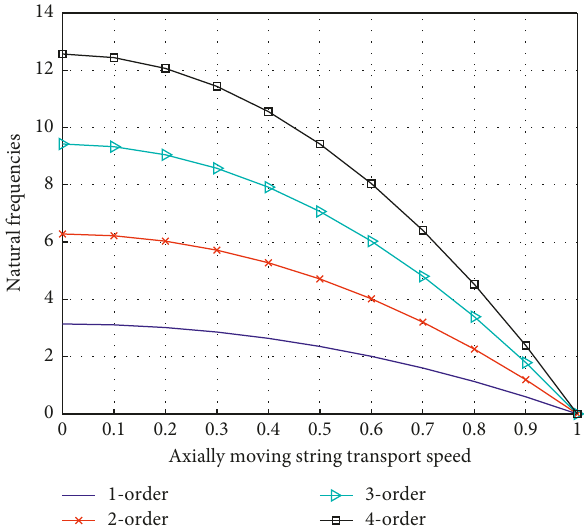
Figure 1: First four-order mode natural frequencies derived from analytical